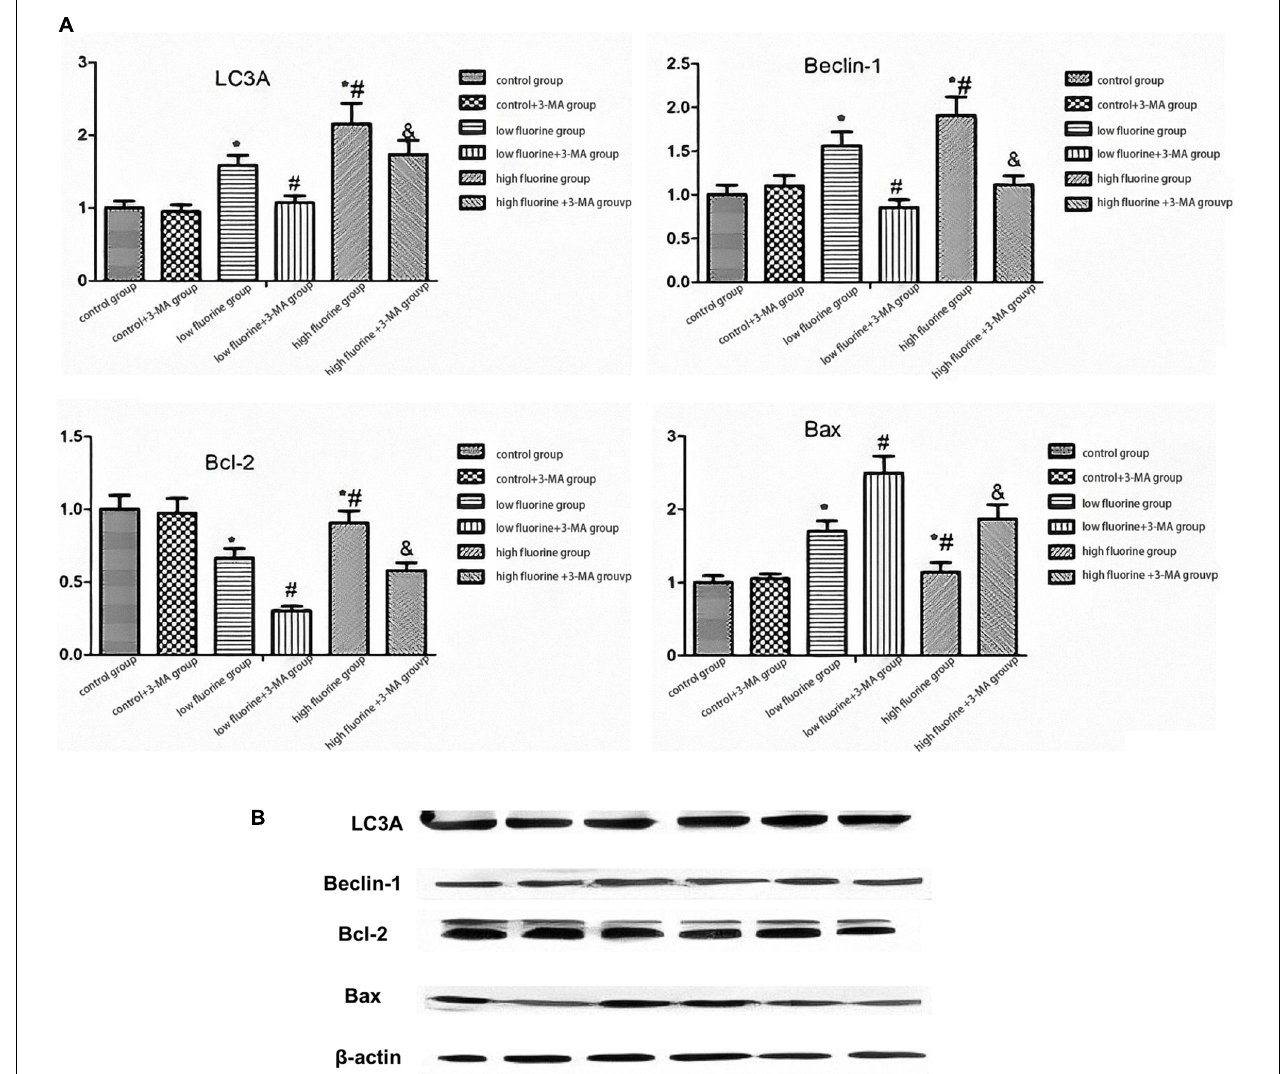
FIGURE 3 | The protein expressions of LC3A, Beclin 1, Bcl-2, and BAX in osteoblasts. The protein expressions of LC3A, Beclin 1, Bcl-2, and BAX in the different groups of osteoblasts were assessed by western blot. (A) Representative blots and (B) quantitative analysis are shown. From left to right: control group; low-fluoride (2.5 mg/L) group; high-fluoride (5 mg/L) group; control + 3-MA (10 mmol/L) group; low-fluoride (2.5 mg/L) + 3-MA (10 mmol/L) group; high-fluoride (5 mg/L) + 3-MA (10 mmol/L) group. * indicates P < 0.05 compared with the control group; # indicates P < 0.05 compared with the low fluoride group; & indicates P < 0.05 compared with the high fluoride